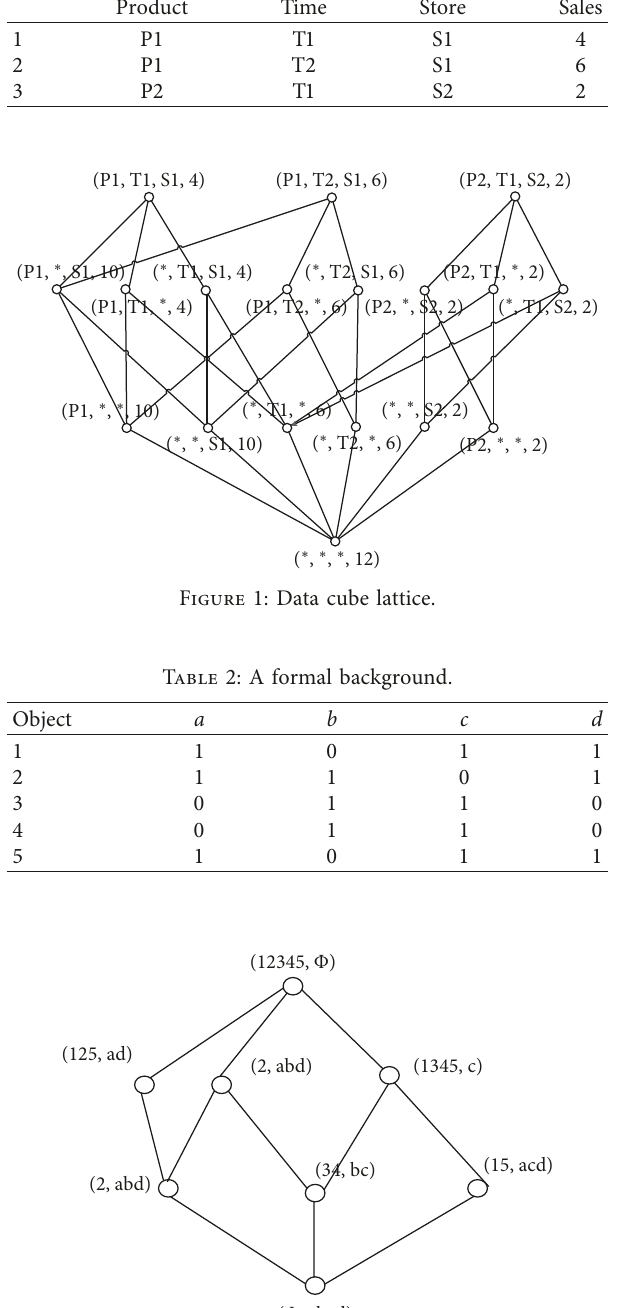
Figure 2: Concept lattice.